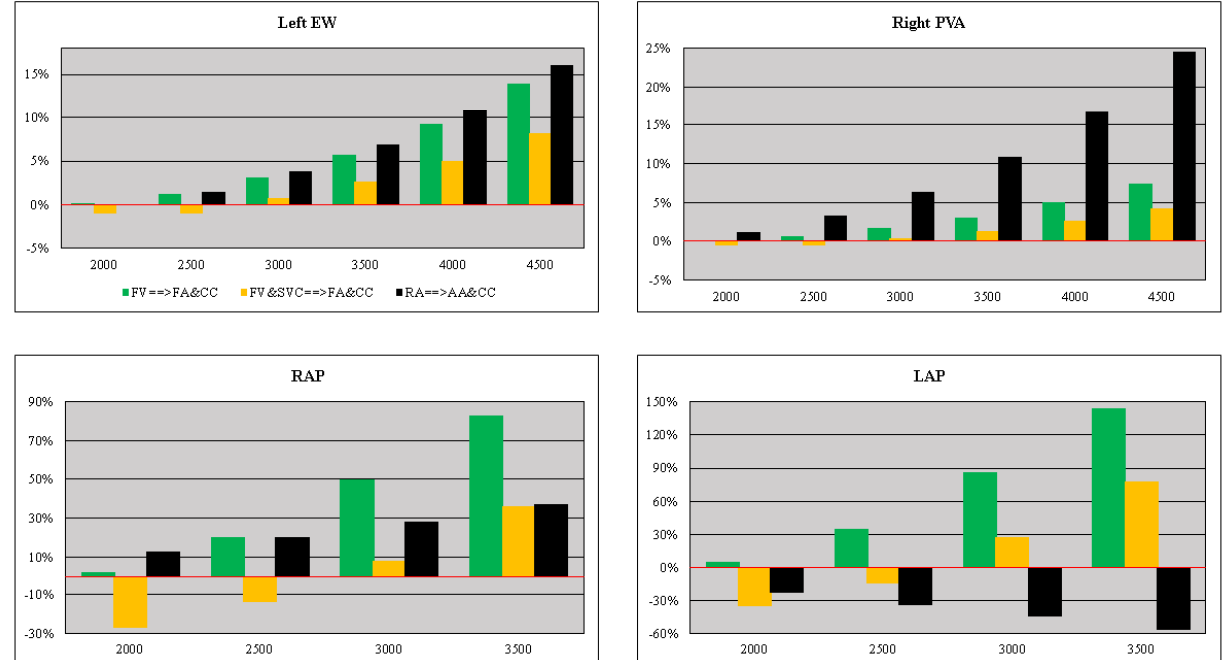
Figure 11. The top-left ( right ) panel shows the relative changes in left (right) ventricular EW (PVA) observed for three different cannulations with pump rotational speed set to 2000, 2500, 3000, 3500, 4000 and 4500 rpm. The bottom left ( right ) panel shows the relative changes in right (left) atrial pressure compared to baseline conditions for FV → FA&CC, FV&SVC → FA&CC and RA → AA&CC cannulation configurations with pump rotational speed set to 2000, 2500, 3000 and 3500 rpm. Percentage variation in RAP (LAP) compared to basal.